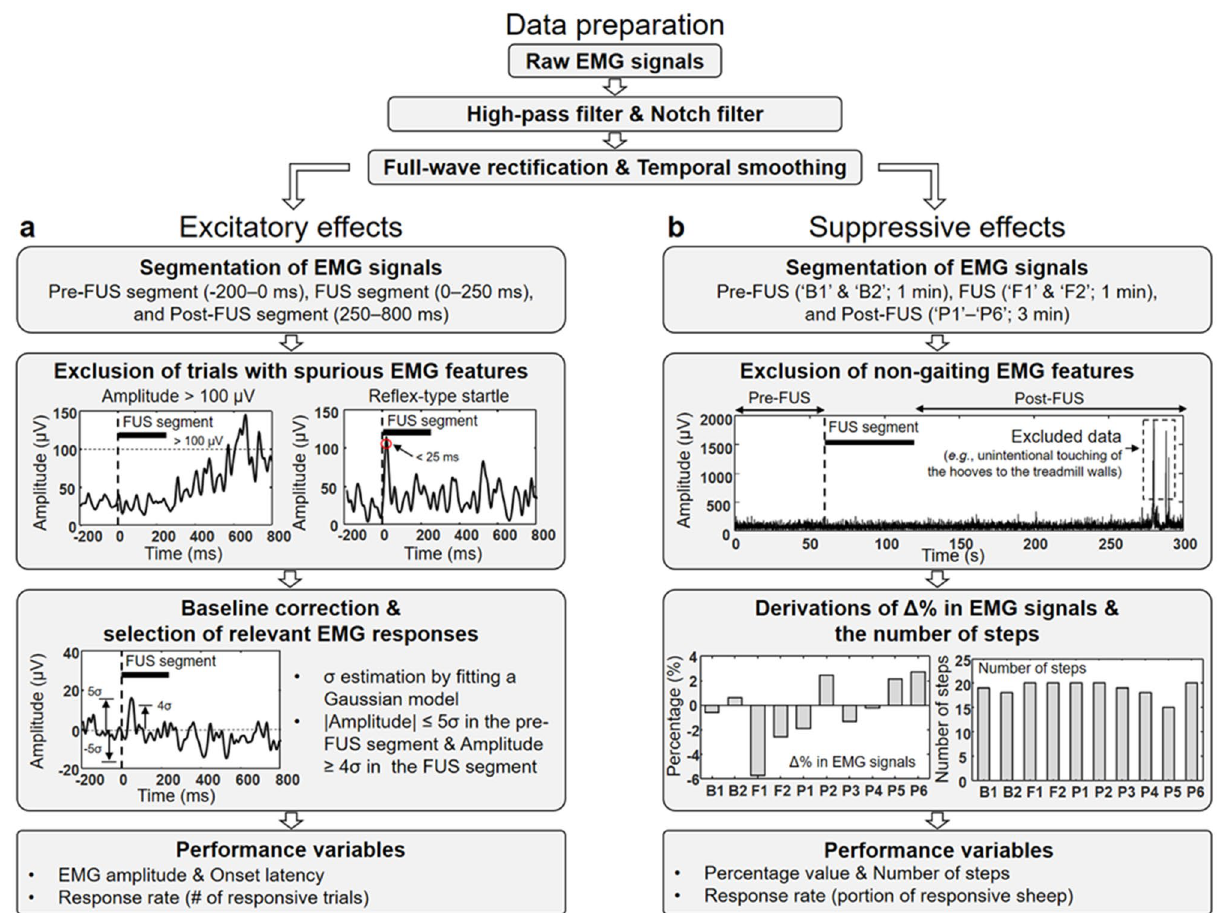
Figure 3. A flow chart of EMG processing and analysis. After preparing the raw EMG data with high-pass/ notch filtering, full-wave rectification, and temporal smoothing (noted as ‘Data preparation’), the EMG data were subjected to two analysis pathways to derive the performance variables to evaluate ( a ) excitatory and ( b ) suppressive effects. σ is the standard deviation of the fitted Gaussian distribution (Supplementary Fig. S1). Δ%, percentage difference; EMG, electromyography; FUS, focused